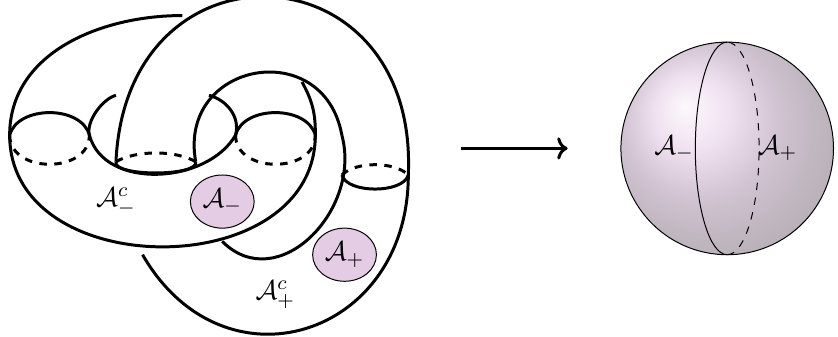
Figure 14 . The (cid:26) for torus is obtained by gluing the path integrals over the two solid tori by A identifying the boundary regions A c and A c on the boundary tori. The resulting path integral is (cid:0) + same as the reduced density matrix (cid:26) for Riemann A